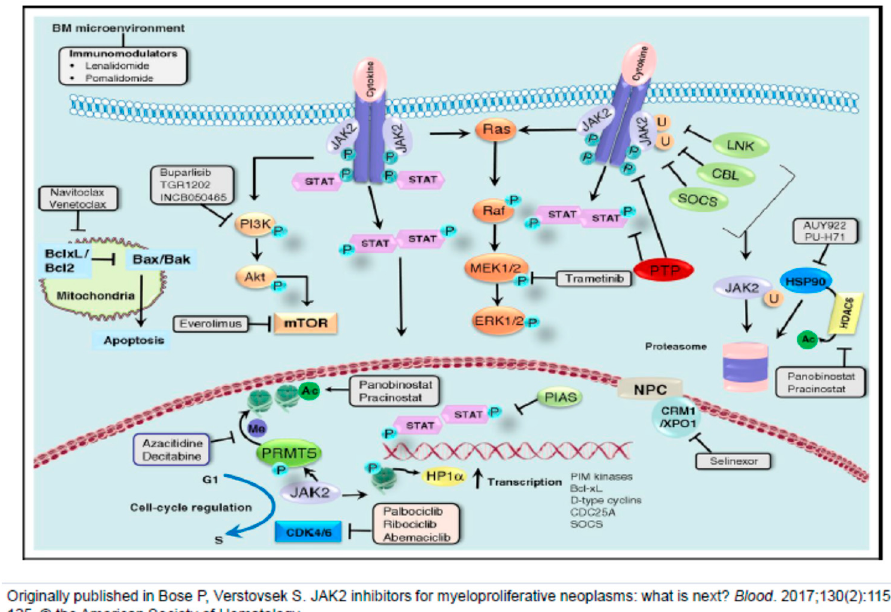
Figure 2. JAK2 transduces cytokine and growth factor signals from membrane-bound